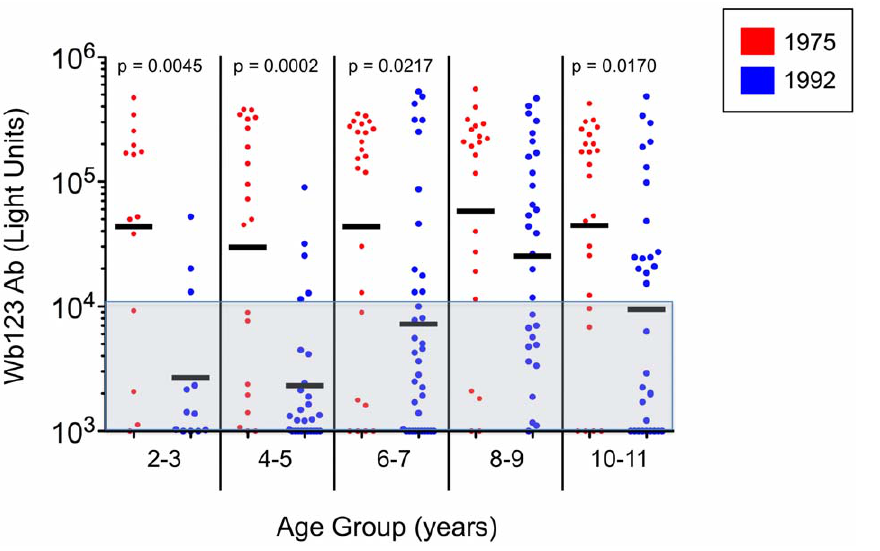
Figure 7. Levels of Ab to Wb123 in Children from 1975 and 1992. Ab levels to Wb123 in children # 11 years old by 2 year age divisions in 1975 (red dots) and 1992 (blue dots). Each dot represents a single individual and the black bars represent the geometric means for each group. The shaded grey area indicates values considered negative and p-values were calculated using the Mann Whitney U test.